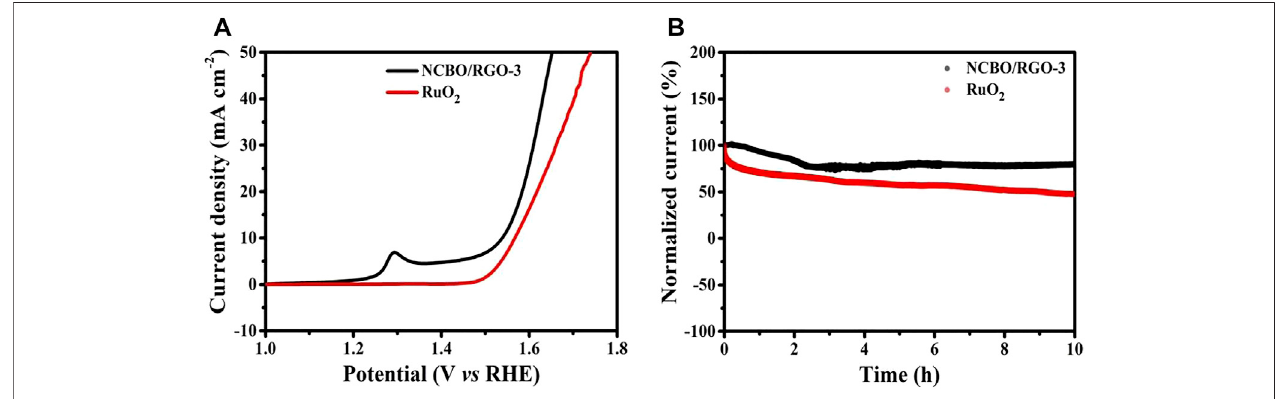
FIGURE 7 | (A) LSV curves of NCBO/RGO-3 and commercial RuO 2 catalyst; (B) The stability tests of NCBO/RGO-3 and commercial RuO 2 catalyst at the current density of 10 mA cm − 2